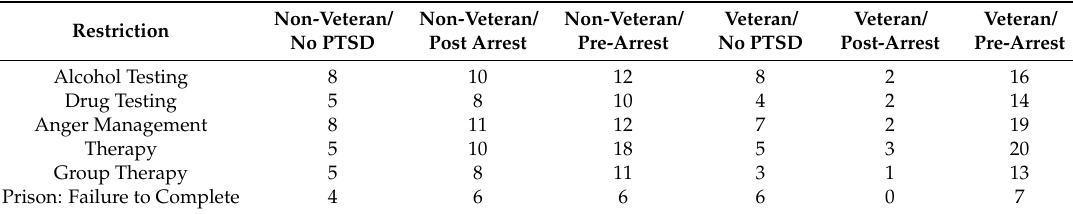
Table 3. Treatment restrictions by